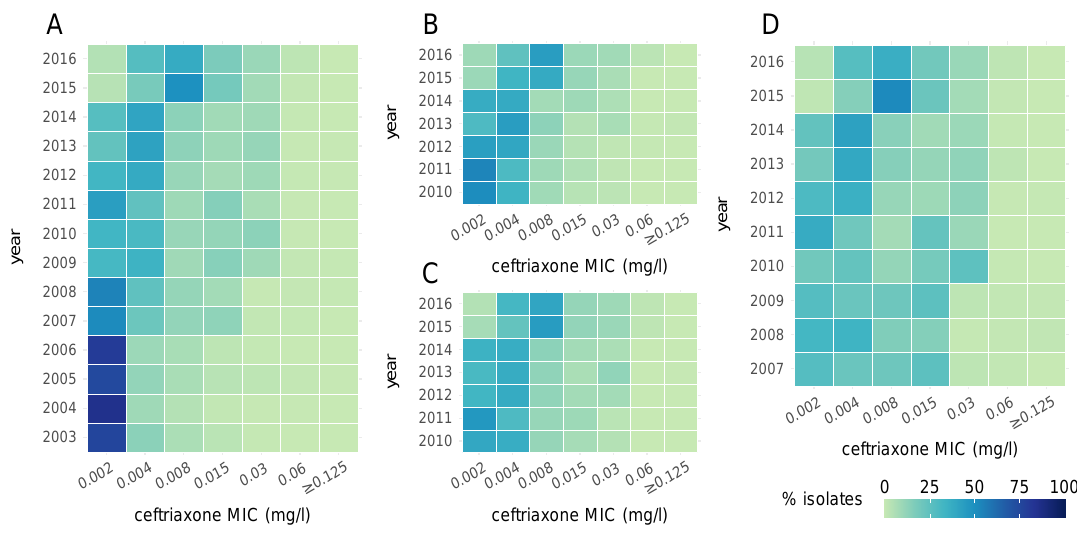
Figure 5. Heat maps showing the ceftriaxone MIC distribution of N. gonorrhoeae in the UK over time: ( A ) from all GRASP samples; ( B ) in women; ( C ) in heterosexual men and ( D ) in